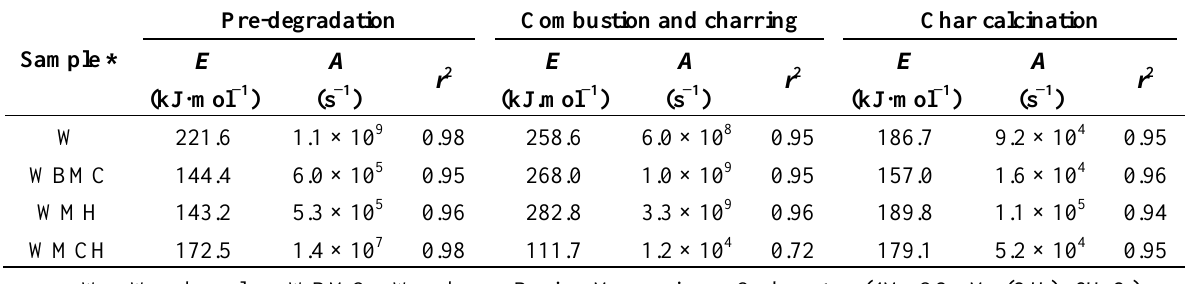
Table 4. Thermokinetic parameters for pyrolysis of fire-retardant treated red gum